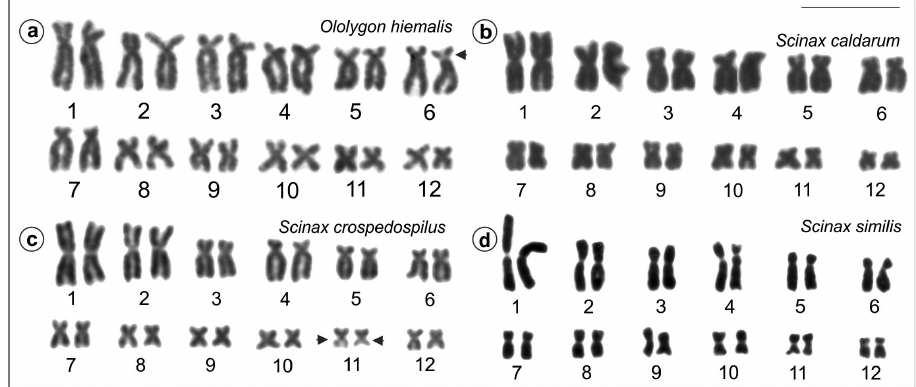
Figure 1. Giemsa stained karyotypes of Ololygon and Scinax species. a O. hiemalis , male b S . caldarum , male c S . crospedospilus , male d S . similis , female, with heteromorphic chromosomes pairs 3 and 4. Secondary constrictions (arrowhead) are visible on chromosome 6 in a and on chromosomes 11 in c . Bar = 10 μm .